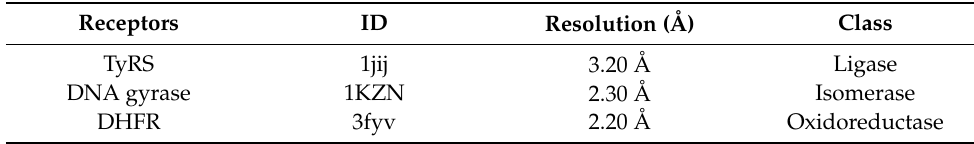
Table 1. Description of the studied receptors.